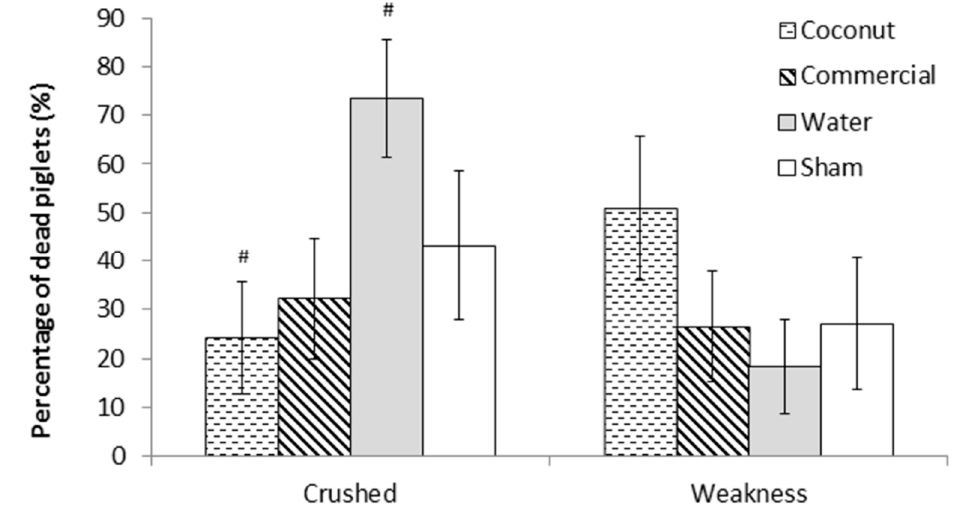
Figure 2. Percentage of dead piglets per main cause of mortality (crushing or weakness). Piglets were either given a 2 mL oral supplementation at 3 h postpartum (Coconut oil, commercial product or water) or were sham-dosed. Tendency for difference between treatments ( p = 0.06) is shown by #.